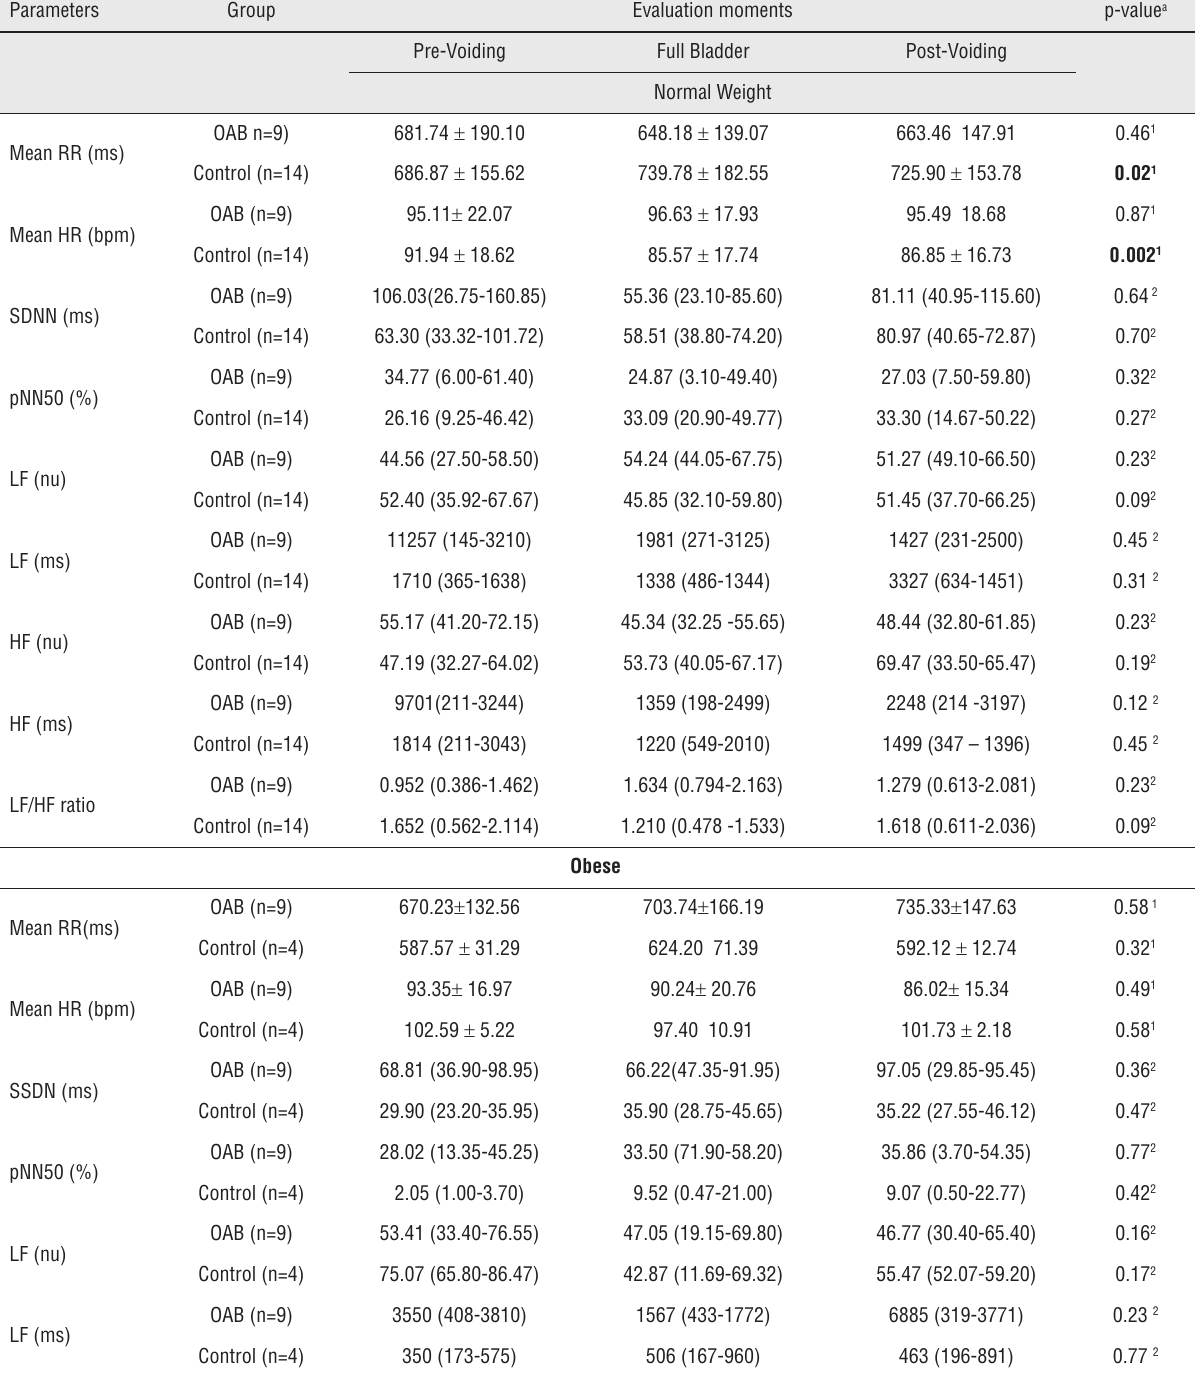
Supplementary Data: Analysis of autonomic parameters in individuals of normal weight and those without constipation in the study groups at three evaluation